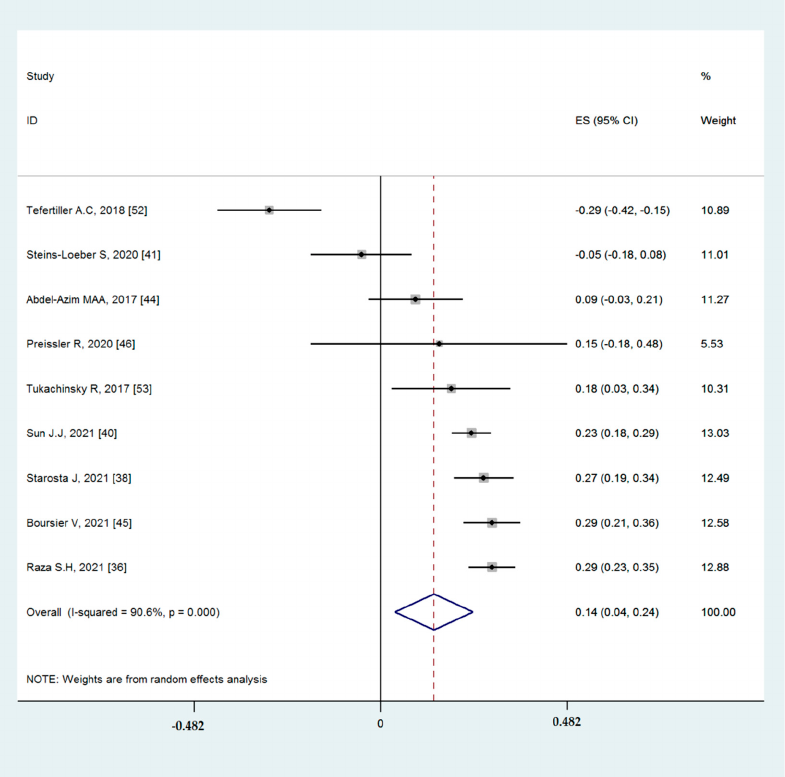
Figure 3. The forest plot displaying the estimated pooled Fisher’s z-score in the association between binge-watching and depression.